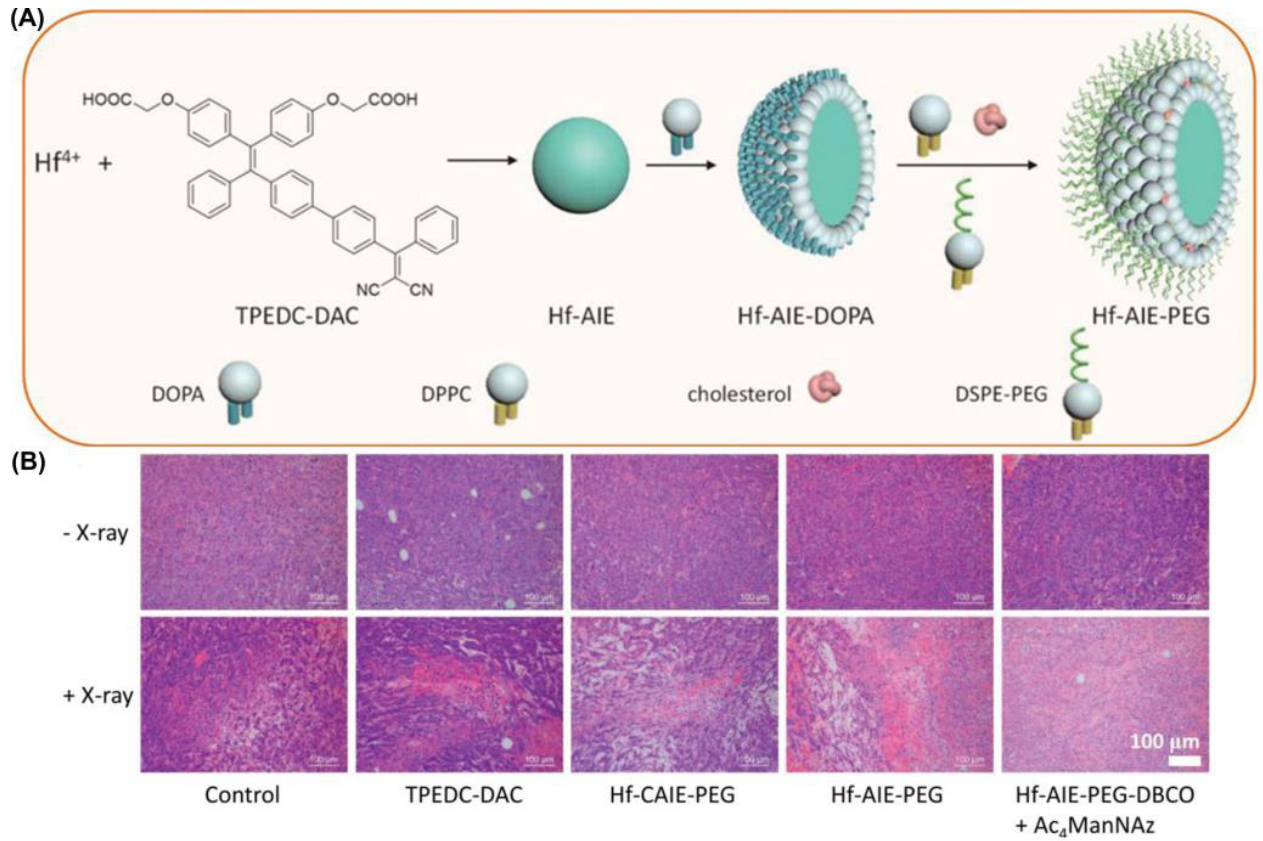
Figure 24. ( A ) Schematic illustration of fabrication of Hf-AIE-PEG; ( B ) H&E staining analysis of tumor tissues treated with various treatments. Reprinted with permission from Ref. [159]. Copy- right 2021 WILEY-VCH.